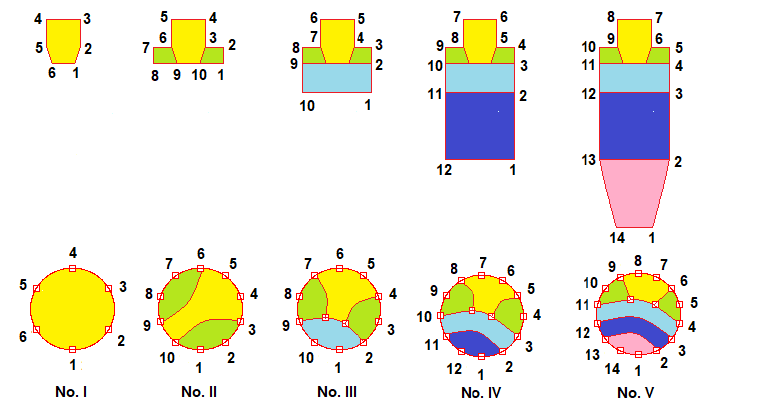
Figure 3 – The graphic visualization of the first graph model for five (I-V) frontal-attacking plane shooting